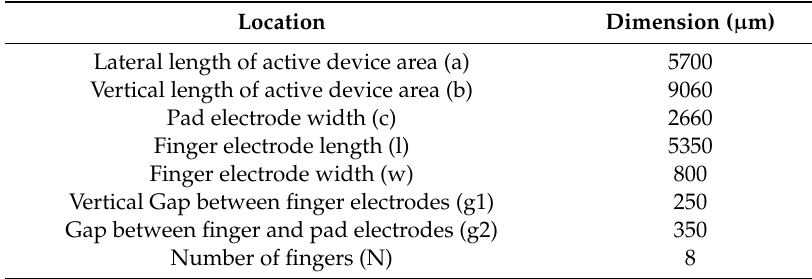
Figure 1. The geometry of the laser-induced graphene (LIG)-micro supercapacitors (MSC) electrode. Table 1. Dimensions of the LIG-MSC electrode.